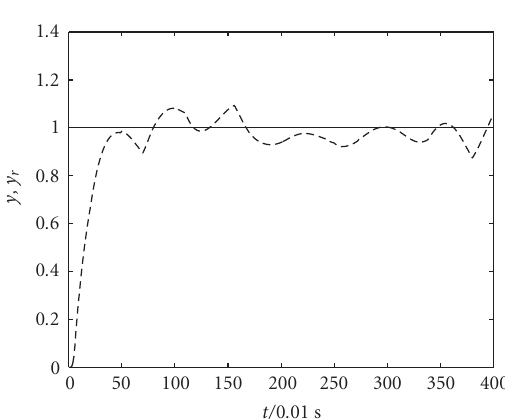
Figure 4.2. Control in set-point tracking.